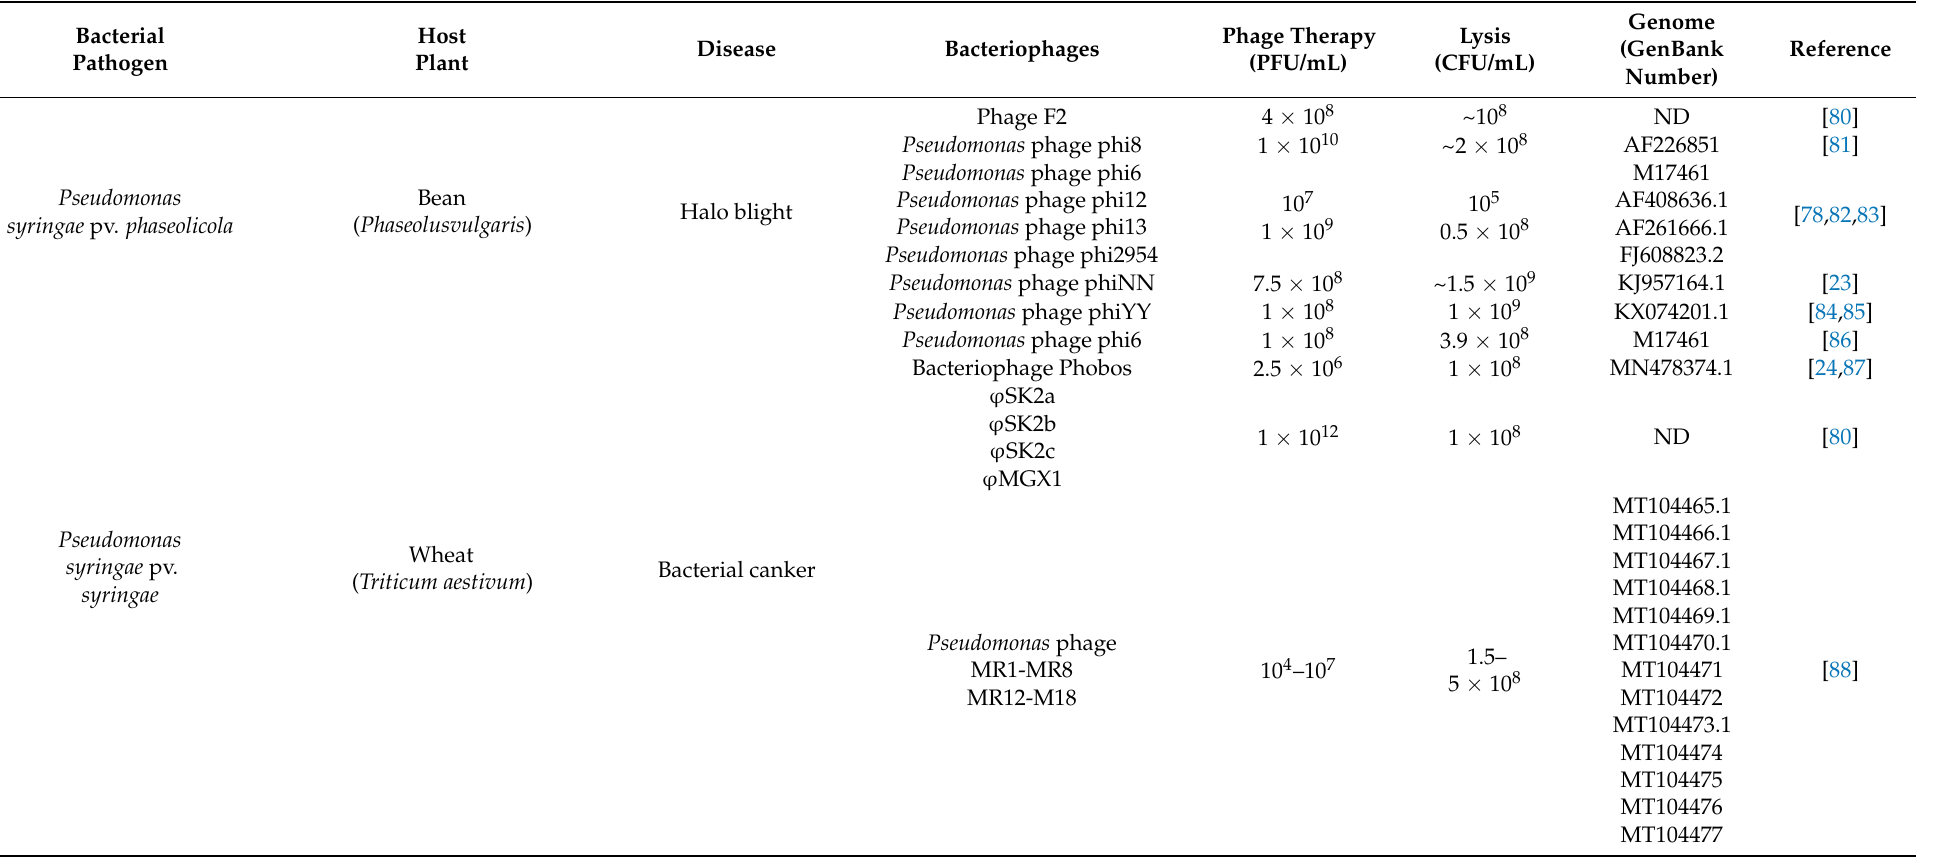
Table 1. Application of bacteriophages as biocontrol agent against bacterial diseases in agricultural crops. Potential bacteriophages against infection by proteobacteria that cause diseases in bean, corn, sugar cane, green chili, tomato, tobacco, maize, potato, rice, pepper, geranium, sweet potato, onion, peach, cabbage, citrus, wheat, brassica, and passion fruit